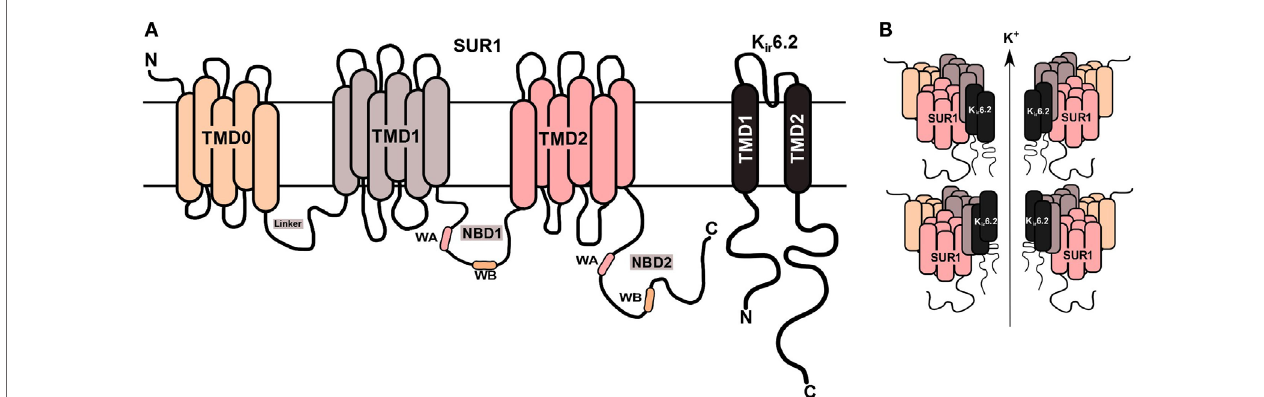
FiGURe 1 | K ATP channel structure on β -cell membrane . (A) The SUR1 subunit is made up of three transmembrane domains (TMD0, TMD1, and TMD2) and two nucleotide-binding domains (NBD1/NBD2), which face the cytoplasm. The NBD’s harbor the Walker A (WA) and Walker B (WB) motifs. K ir 6.2 is the pore-forming subunit, containing two membrane-spanning domains, connected by an extracellular pore-forming region and cytoplasmic –NH 2 and –COOH terminal domains. (B) Illustration of the predicted octameric structure of K ATP channels, comprising four K ir 6.2 and four SUR1